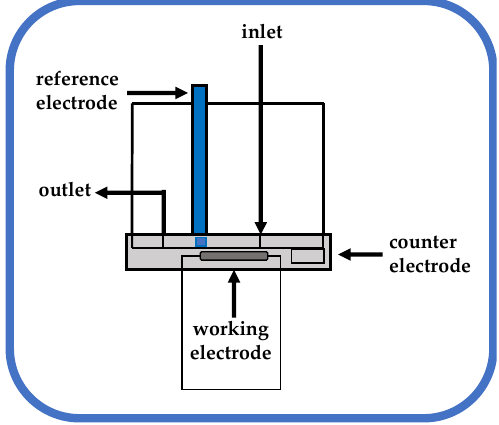
Figure 3. Scheme of electrochemical cell. (from ref. [20]).